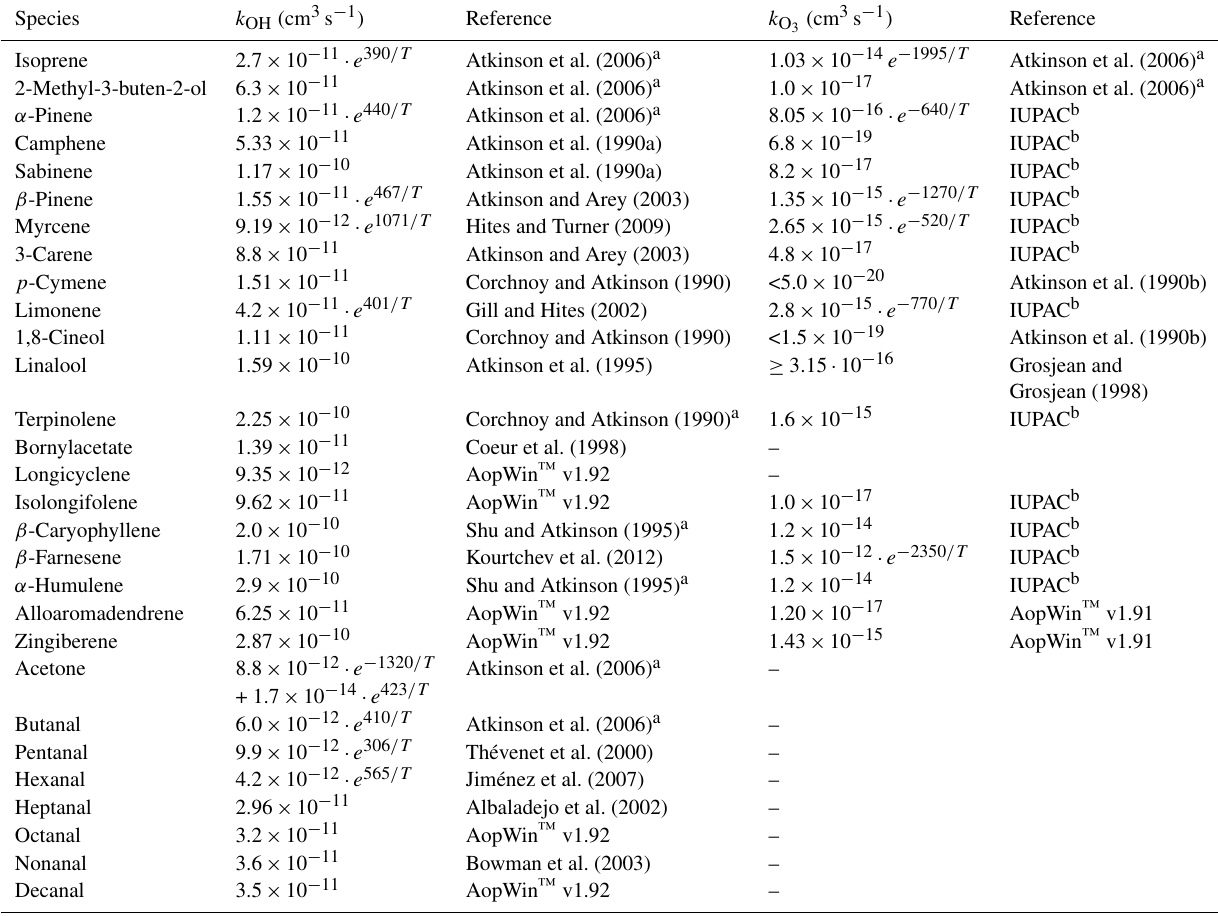
Table 1. OH and O 3 reaction rate coefficients used in reactivity calculations. Species